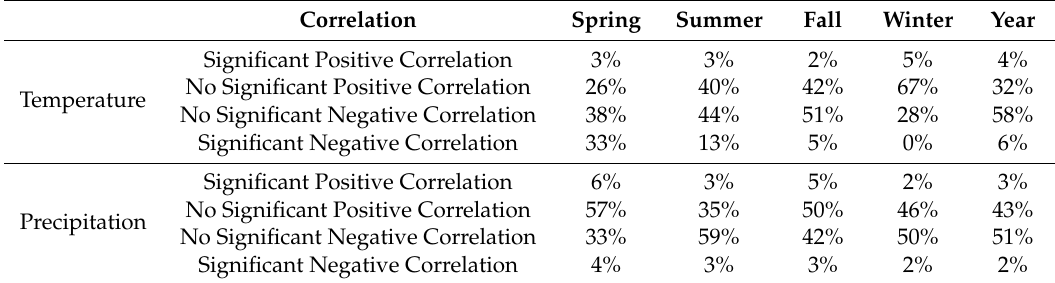
Figure 5. Correlation coefficients between the SOS and temperature ( a ) and between the SOS and precipitation ( b ). Table 2. Percentages of the correlation coefficients between the SOS and temperature and precipitation (Significant Positive Correlation ( r > 0, p < 0.05): No Significant Positive Correlation ( r > 0, p > 0.05), No Significant Negative Correlation ( r < 0, p > 0.05), Significant Negative Correlation ( r < 0, p < 0.05)).